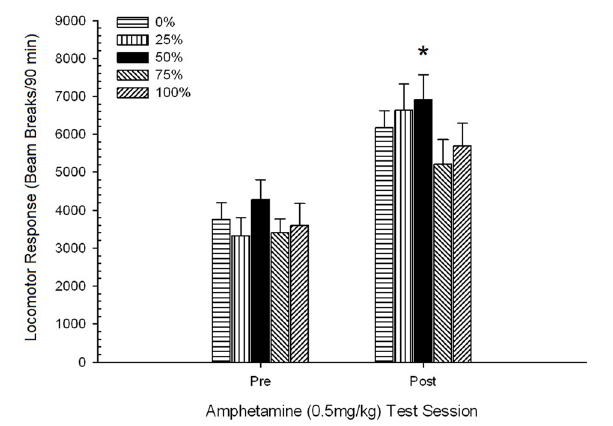
FIGURE 5 | Mean (SE) locomotor response (number of beam breaks in an electronic array per 90min) to 0.5mg/kg d-amphetamine on separate sessions before and after a 5-session sensitizing regimen of d-amphetamine (1.0mg/kg; i.p. per session) in groups of Sprague Dawley rats ( n = 8/group) previously exposed to 15 daily conditioning sessions with sucrose reward (10% solution) delivered under 0, 25, 50, 75, or 100% variable schedules. The conditioned stimulus was a light (120s). Group 0 received the same number of rewards as group 100 in the absence of conditioned stimuli. ∗ p < 0 . 05 for mean difference between group 50 and group 0 as well as group 100, based on planned